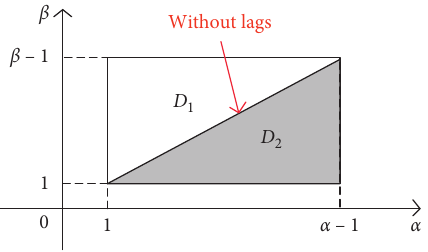
Figure 5: Geometric distribution of α and β